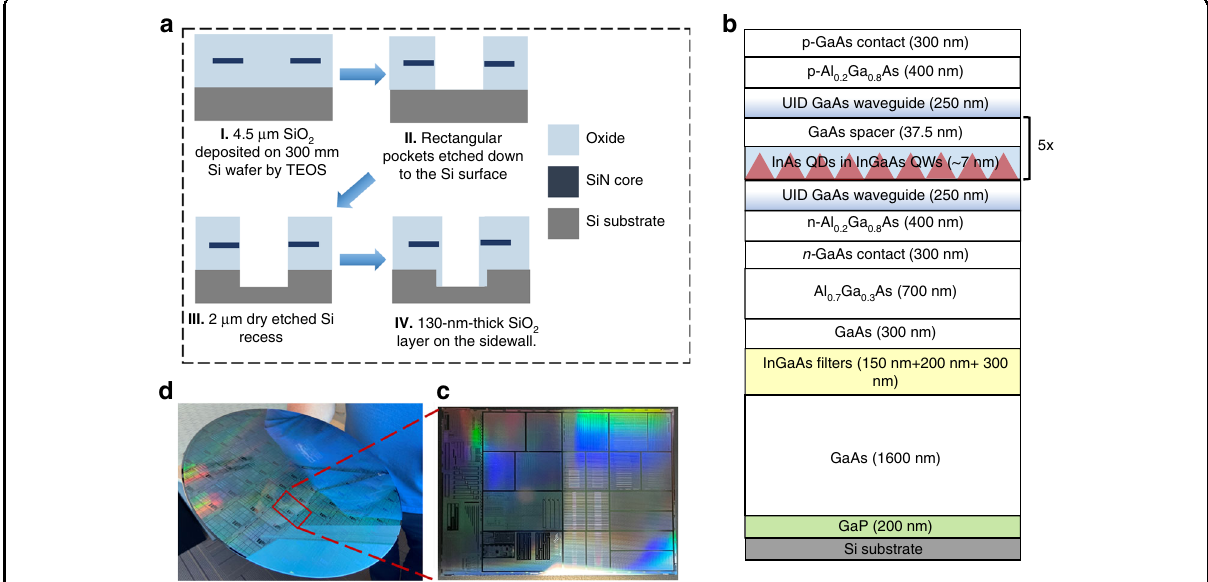
Fig. 1 Template preparation and proposed laser stack. a Schematic diagram of the pattern formation process before III – V deposition. b Simpli fi ed III – V laser stack. c The diced coupon from the as-patterned 300 mm Si wafer for growth condition investigation. d As-patterned 300 mm Si